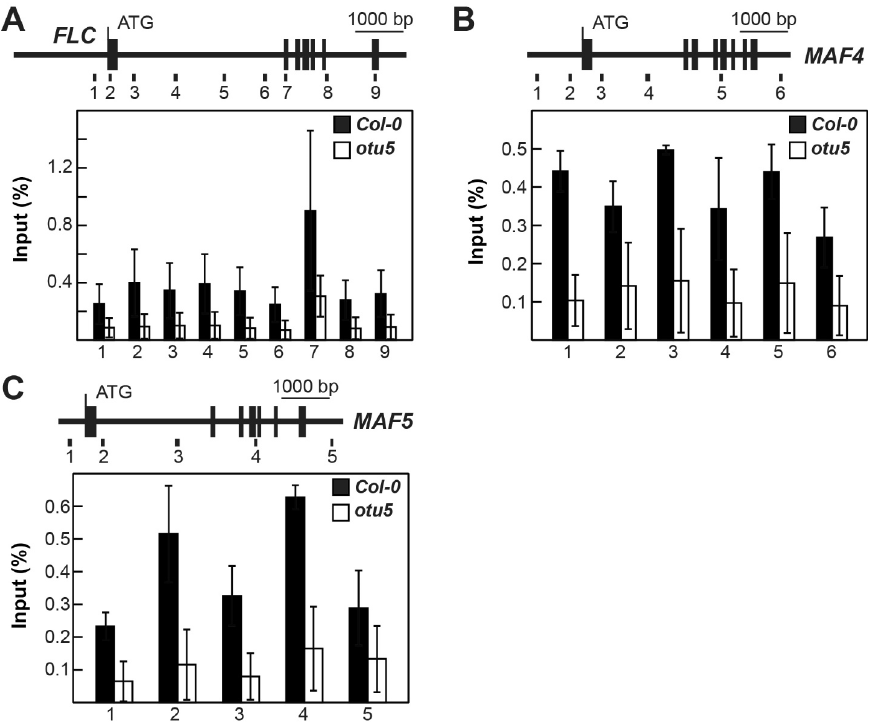
Figure 7. The Arabidopsis OTU5 protein associates with FLC , MAF4 , and MAF5 loci. ( A – C ) The association of OTU5 with various regions of FLC ( A ), MAF4 ( B ), and MAF5 ( C ) was analyzed using qCHIP. The percentage qChIP amplification yields was shown, in comparison with those amplified from input DNA, from nine, six, and five regions on FLC , MAF4 , and MAF5 , respectively. The same regions (depicted in the top panels) analyzed for various histone marks in Figures 4 and 5 were analyzed using antisera against OTU5b for otu5-1 and Col-0 seedlings. Error bars indicate standard deviations.